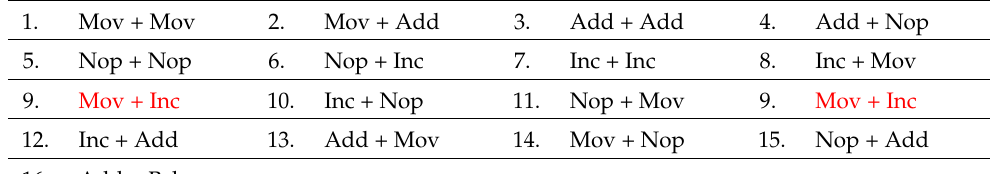
Table 4. Execution sequence patterns of Table 1 (considering the DUT’s two-stage pipeline architecture).